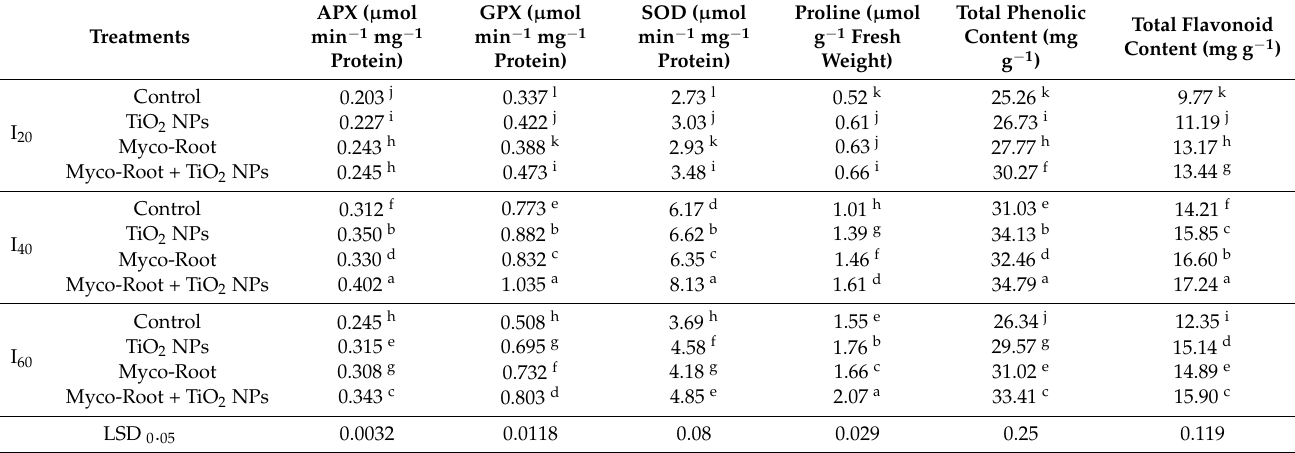
Table 7. Antioxidant enzymes activity, proline, and total phenolic and flavonoid content of pepper- mint leaves in different irrigation regimes and fertilizer